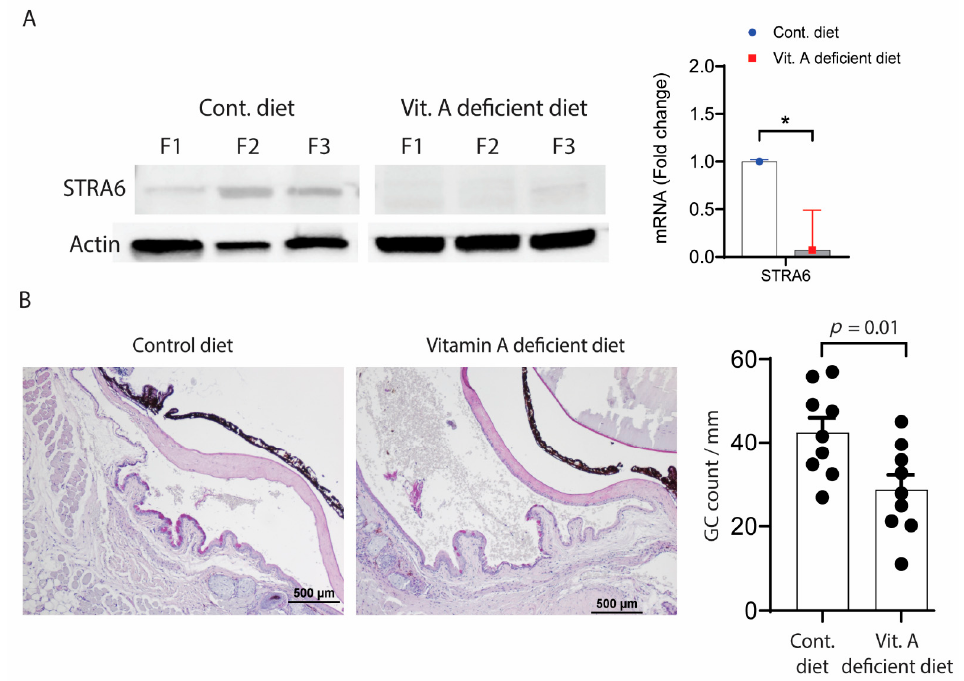
Figure 3. ( A ) Stimulated by retinoic acid 6 (STRA6) expression. Left. STRA6 in the cornea epithelium is downregulated with vitamin A deficiency. Western blot for STRA6 and β -actin in the cornea epithelium of C57BL/6 mice fed a normal vitamin A containing (control) or vitamin A deficient diet from three different biological samples from each group. Right. Relative fold expression of STRA6 mRNA in the conjunctiva of B6 mice on control or vitamin A deficient diet. ( B ) Vitamin A deficiency causes conjunctival goblet cell loss. Left. Representative images of filled goblet cells (GCs) counted in periodic acid Schiff (PAS) stained sections in the GC-rich zone of the conjunctiva of C57BL/6 mice fed a control or vitamin A deficient diet. Right. Each graph bar represents mean + standard deviation of goblet cells/mm. Individual dots represent average of right and left eyes per mouse ( n = 9 per group). * p = 0.01.